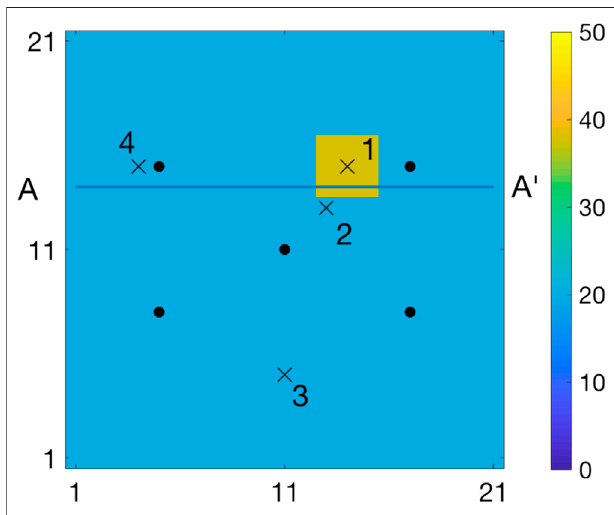
FIGURE 1 | Initial state with observation locations (·) and monitoring locations (×)